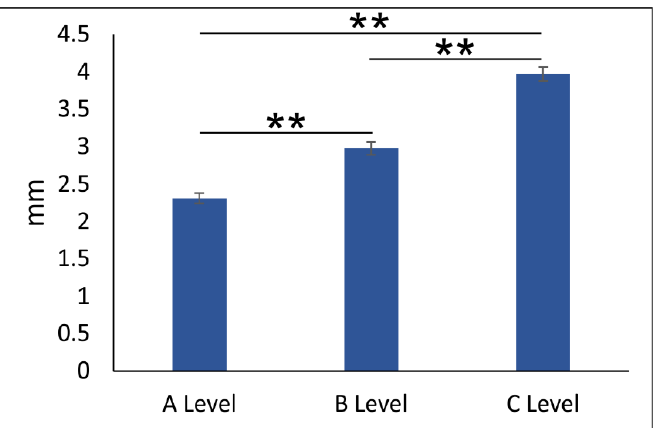
Figure 5. The distance between NPC and central incisors at different levels of anterior maxilla. Bars represent the mean ± SEM. ** denotes a significant difference of p < 0.01.